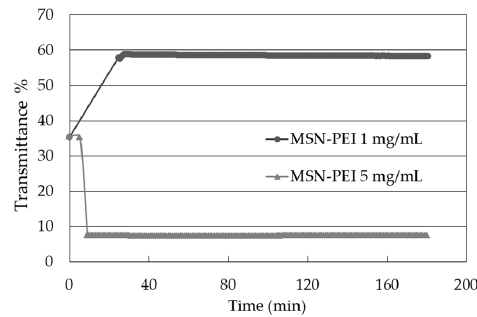
Figure 3. The mean transmittance (T%) of MSN–PEI 1 and 5 mg/mL measured with multiple light scattering over time.